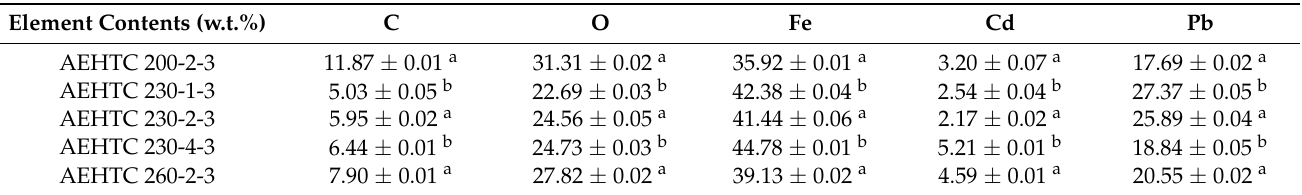
Table 2. Distribution of main elements on the surface and near-surface of AE-CMIW hydrochar after the adsorption